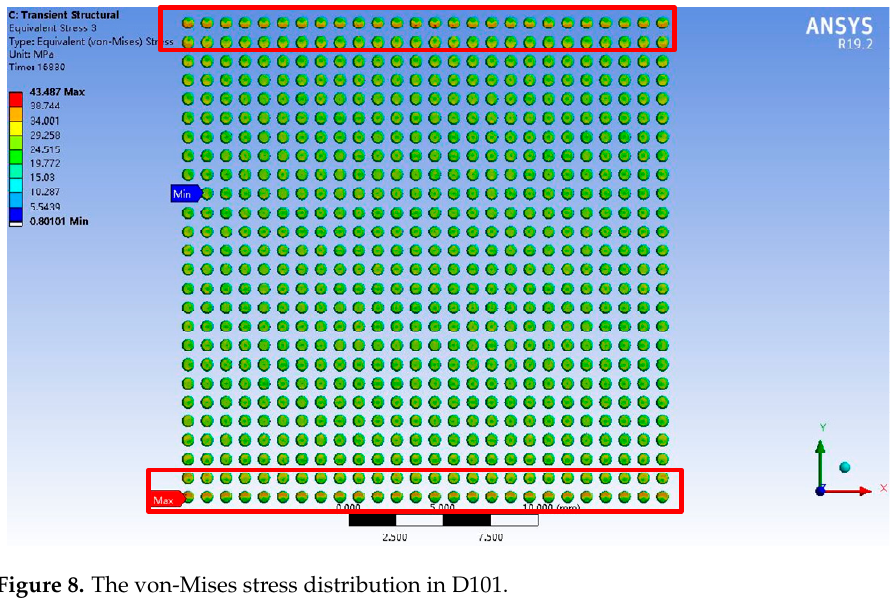
Figure 8. The von-Mises stress distribution in D101.